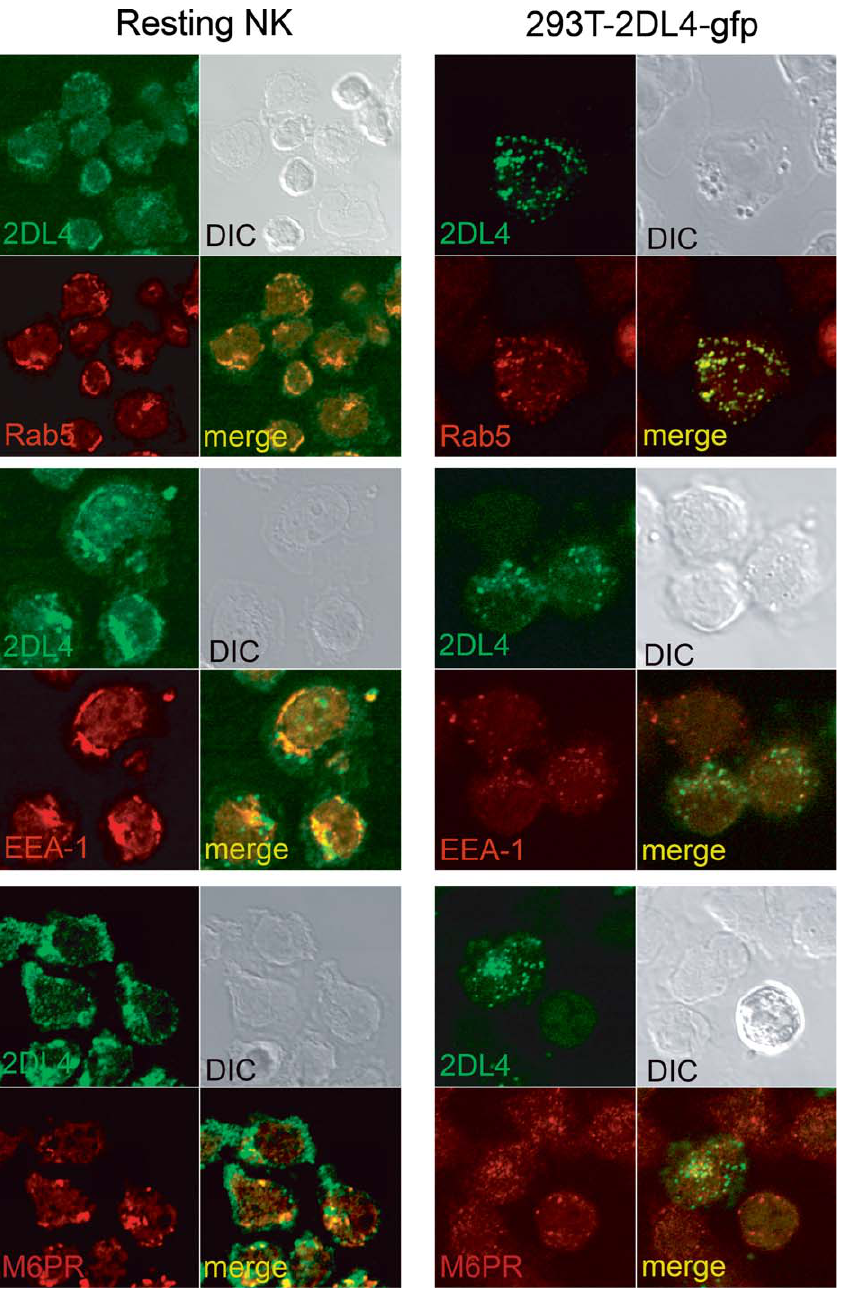
Figure 5. KIR2DL4 Resides in Endocytic Compartments Resting NK cells and 293T-2DL4-gfp cells were fixed, permeabilized, and stained with antibodies against Rab5, EEA-1, and M6PR, followed by Alexa-568– conjugated secondary antibodies. NK cells were further stained with mAb 33 coupled to Alexa-488 to detect